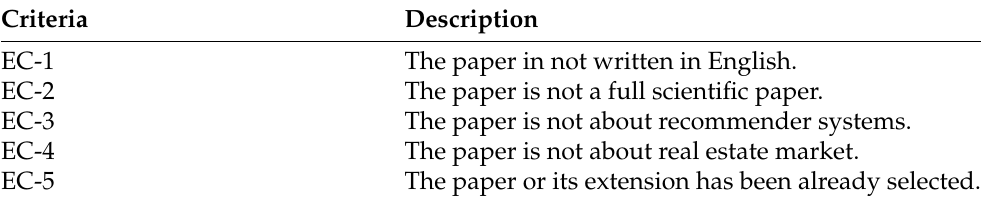
Table 1. Exclusion criteria.